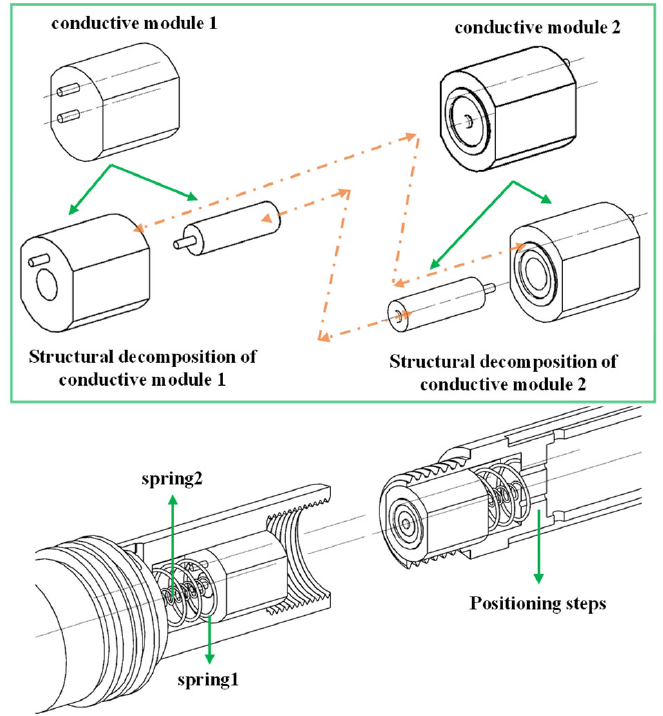
Figure 17. Structural separation of the conductive modules.